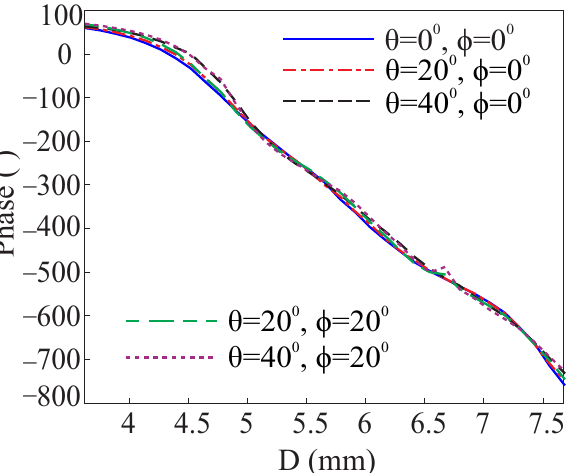
Figure 5. Normalized reflection phase curves at 11.725 GHz for various oblique incidence.